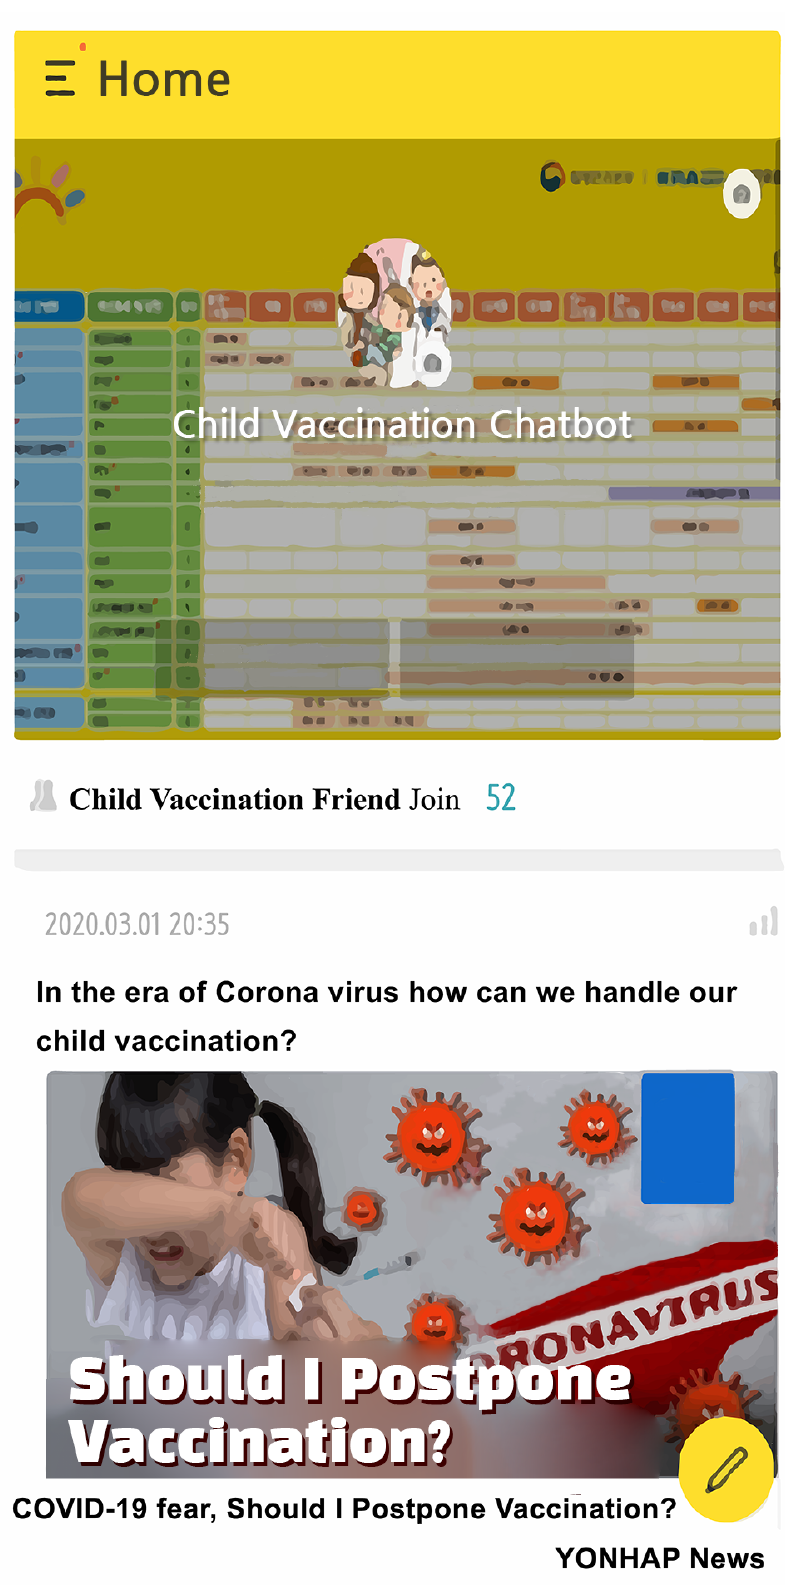
Figure 1. The main screen of the child vaccination chatbot.